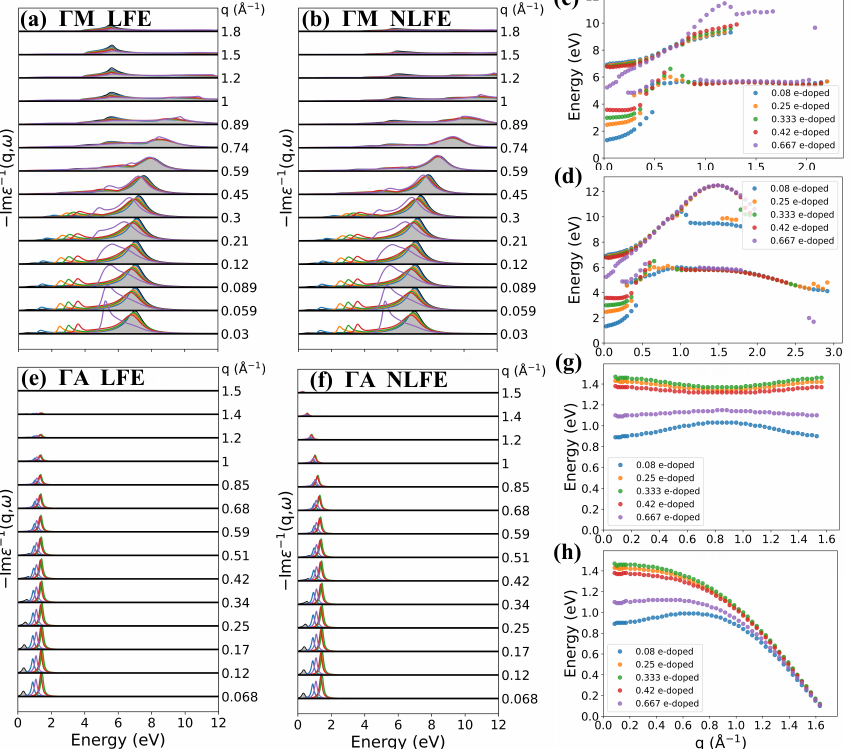
Figure 4. Calculated loss functions along the Γ M direction ( a ) with LFE, ( b ) without LFE and along the Γ A direction ( e ) with LFE, ( f ) without LFE at different doping levels (light blue line for 0.08 e-doped, orange line for 0.25 e-doped, green line for 0.333 e-doped, brown line for 0.42 e-doped and violet line for 0.667 e-doped per unit cell). ( c , d , g , h ) show positions of peaks of ( a , b , e , f ), respectively. The shaded background gives the loss functions of the no-doping case for